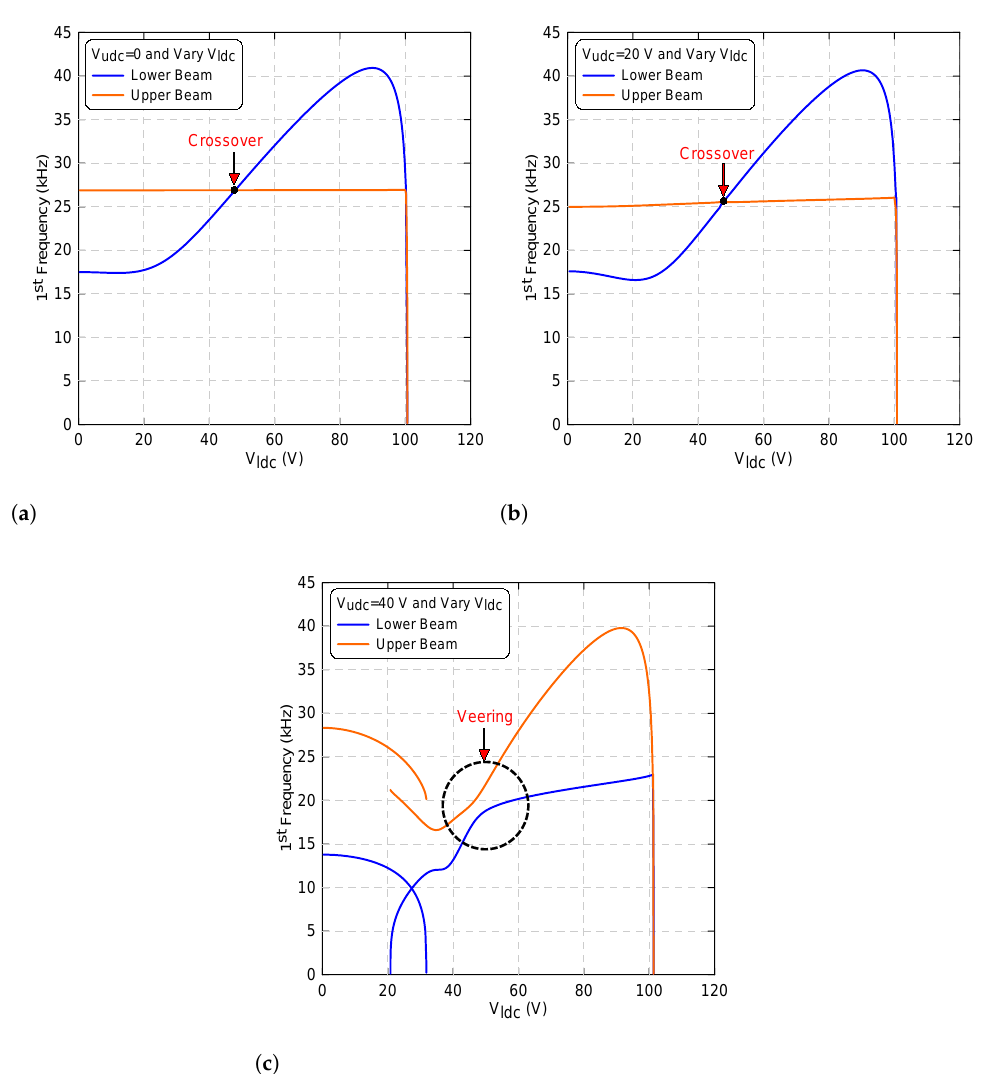
Figure 6. The variation in the first resonance frequency of the lower beam f l 1 and of the upper beam f u 1 as a function of the lower static voltage using three-symmetric modes ROM and an upper voltage sets to: ( a ) V udc = 0, ( b ) V udc = 20 V and ( c ) V udc = 40 V. The lower beam results are marked with blue lines and the upper beam results are marked with orange